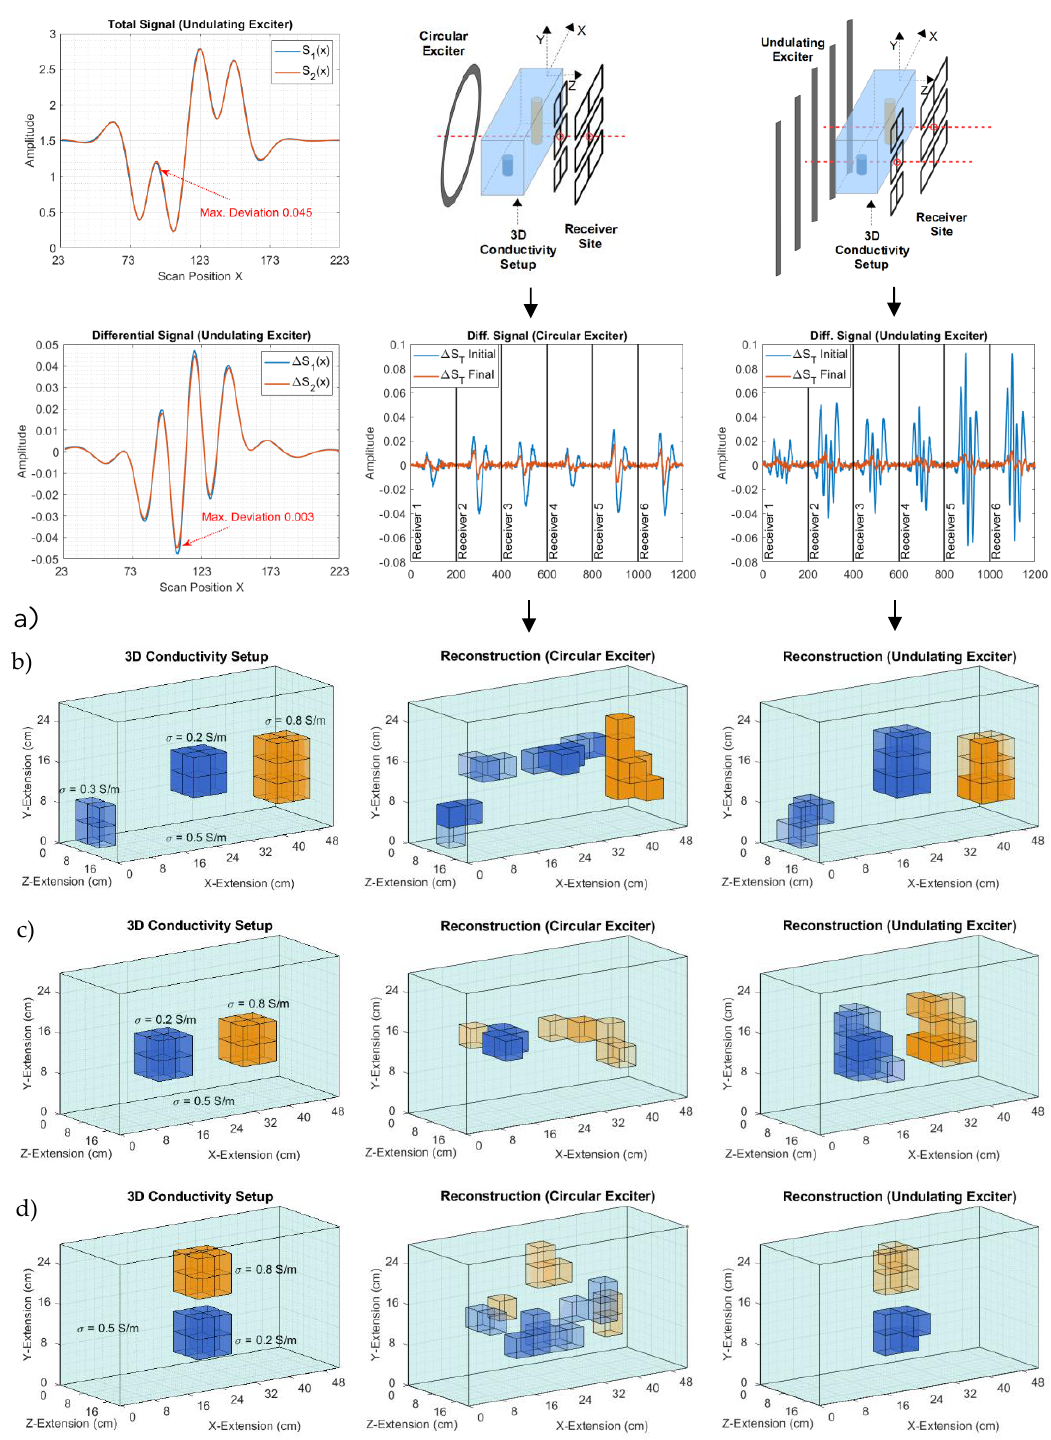
Figure 14. 3D reconstructions from the emulated measurements with 50 dB SNR. ( a ) Computed signals from a cuboid with an ideal undulator and an 11-wire undulator (no noise added in this presentation); ( b ) Measurement setup, noise affected signals, and 3D reconstructions are compared for a circular coil and an 11-wire undulator; ( c ) and ( d ) Other perturbations inside the cuboidal volume. Note that here, with the number of voxels (455) and the length of the signal vector ( 6 × 200 =